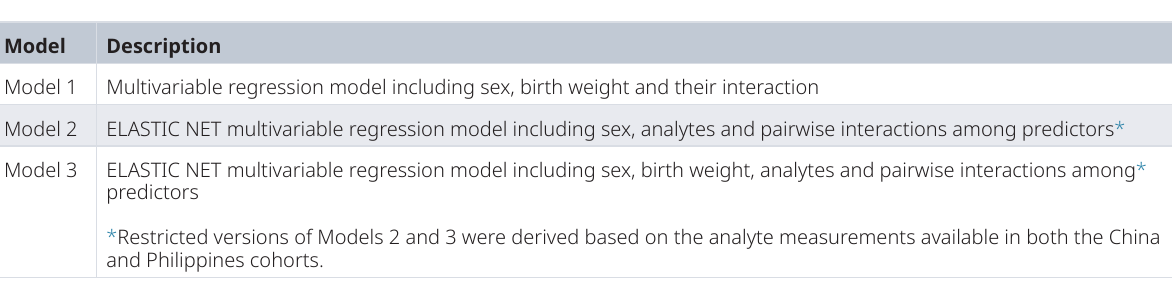
Table 2. Summary of models developed and